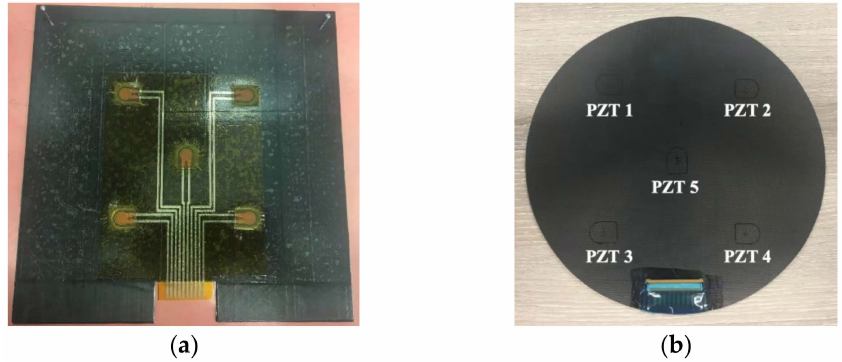
Figure 2. Schematics of ( a ) embedding procedure and ( b ) trimmed smart repair patch.